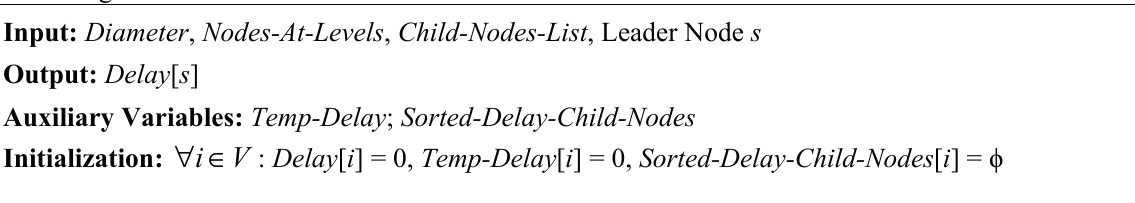
Algorithm 6. Pseudo Code for an Algorithm to Determine the Minimum Aggregation Delay of a Data Gathering